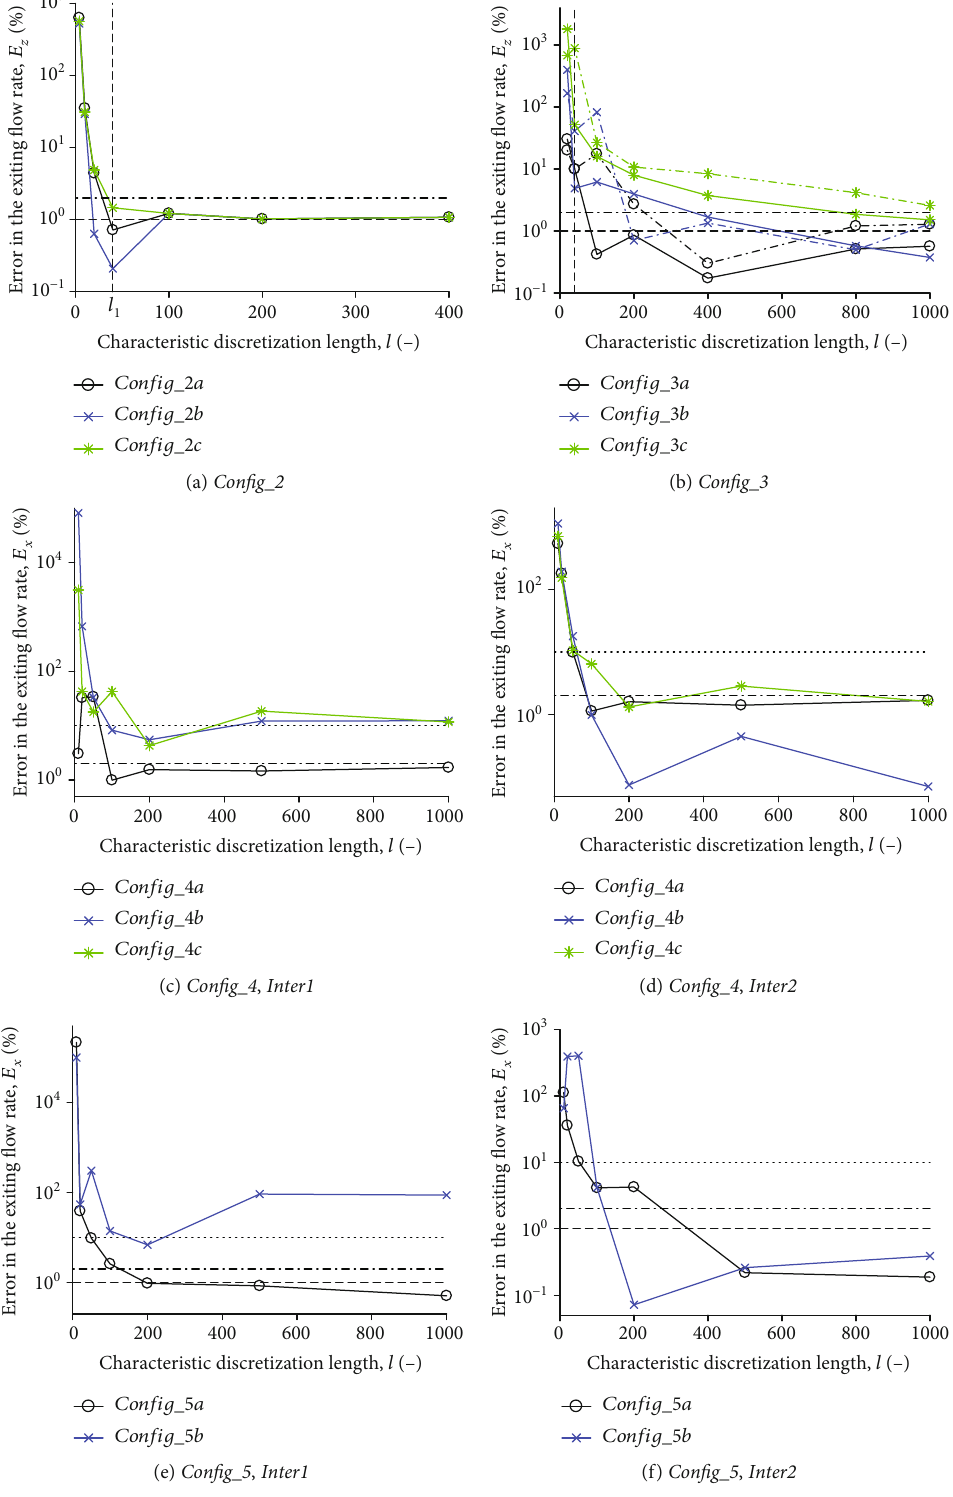
Figure 8: Error in the exiting fl ow rates (a, b) E L = 10 m for the fracture networks (a) Con fi g_2 (Figures 6(a) – 6(c)), (b) Con fi g_3 (Figures 6(d) – 6(f)), (c, d) Con fi g_4 (Figures 7(a) – 7(c)), and (e, f) Con fi g_5 (Figures 7(d) and 7(e)). The method Inter1 is used in (b, full lines), (c), and (e) to de fi ne the subfractures of the systems and the method Inter2 in (b, dotted lines), (d), and (f). The dashed, dashdot, and dotted black lines with no symbol represent errors of 1, 2, and 10 % ,